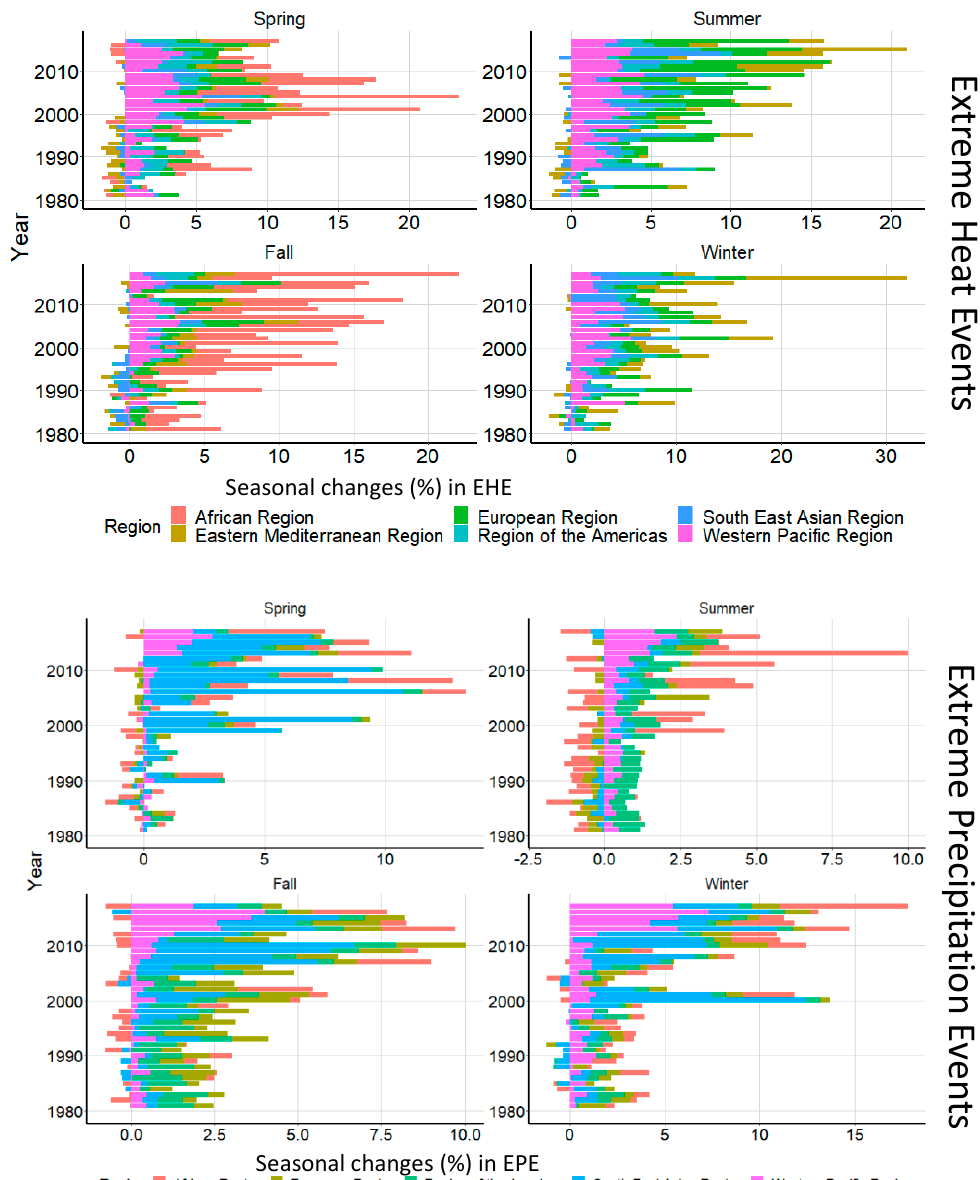
Figure 3. Seasonal changes in EHE ( top ) and EPE ( bottom ) during 1980–2017. Based on regression analysis, we identified the top 10 metropolitan locations with the highest seasonal rate of increases in EHE and EPE frequencies (Figure 4). Six out of the top ten cities with the highest seasonal increases in EHE frequency during spring and summer are from North Temperate zones, while eight out of the top ten cities with the highest rate of increasing EHE frequency in fall and winter are from North Tropic zones (Figure 4A). In contrast, the majority of cities with the highest rate of increases in EPE were from North Temperate zones, irrespective of the season (Figure 4B).